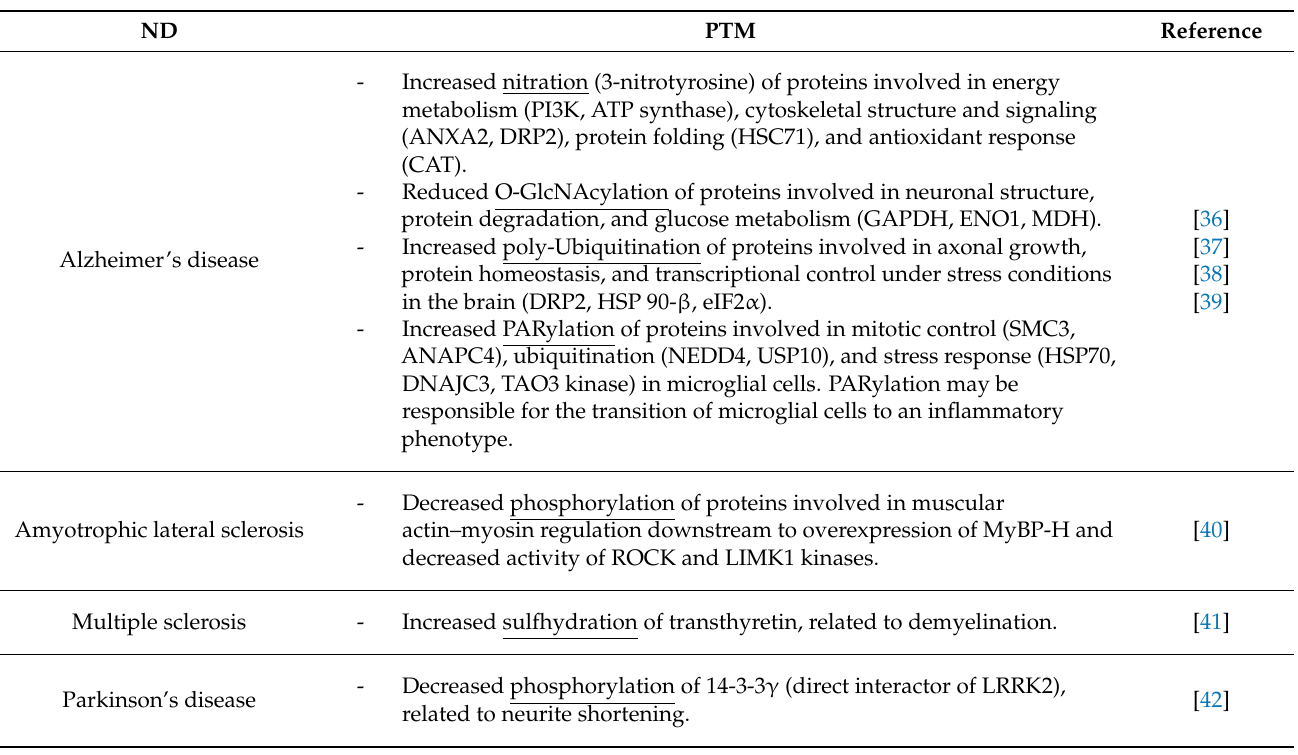
Table 2. Outline of the most recent pathogenic PTMs discovered in NDs by Italian proteomics studies.